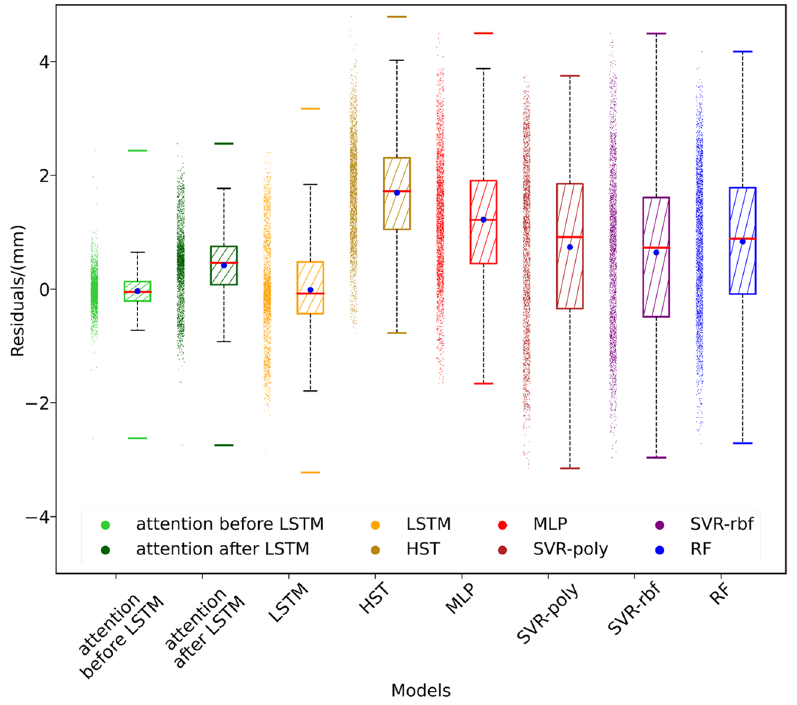
Figure 11. Comparison of the inherent stability and predictive performance of different models.